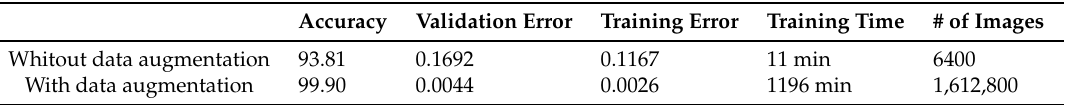
Table 8. Comparison of obtained accuracy, validation error, training error, and training time when using data augmentation with respect to the original